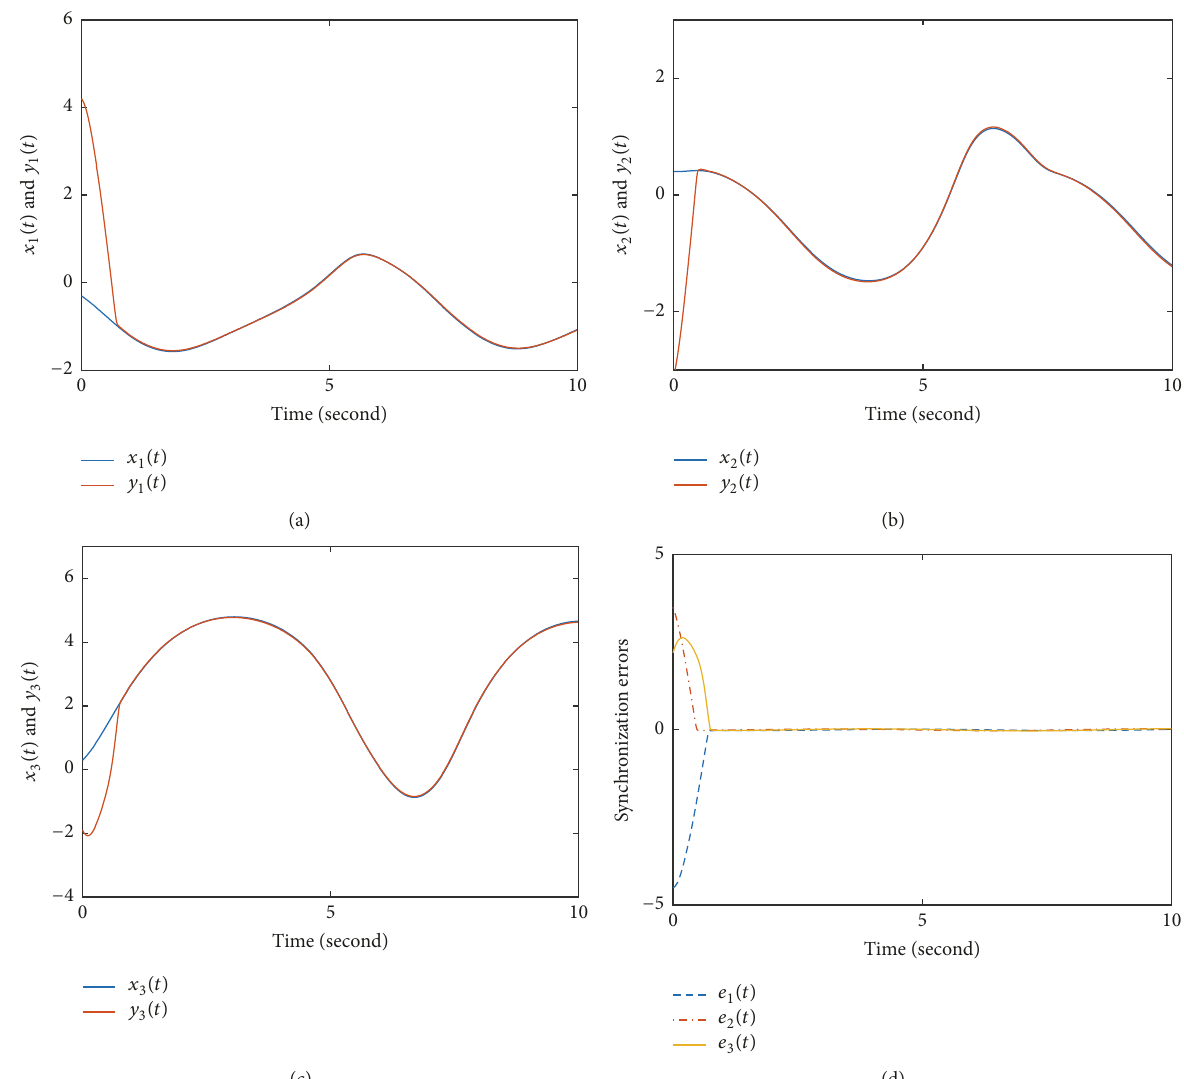
Figure 4: Simulation results in (a) 𝑥 1 (𝑡) and 𝑦 1 (𝑡) ; (b) 𝑥 2 (𝑡) and 𝑦 2 (𝑡) ; (c) 𝑥 3 (𝑡) and 𝑦 3 (𝑡) ; (d) synchronization